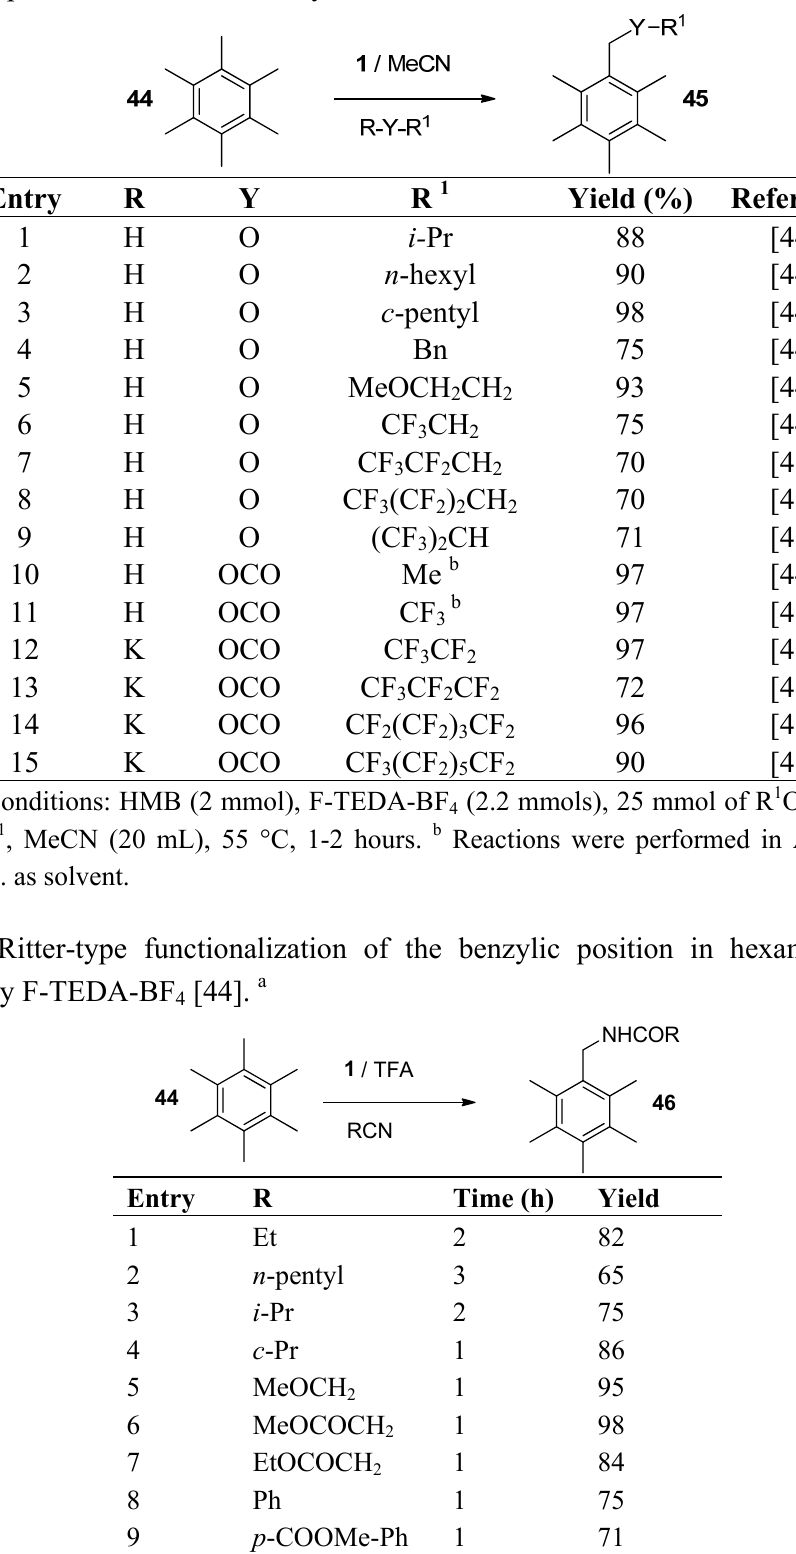
Table 3. Reactions of hexamethyl benzene 44 with F-TEDA-BF alcohols or potassium salts of carboxylic acids. a